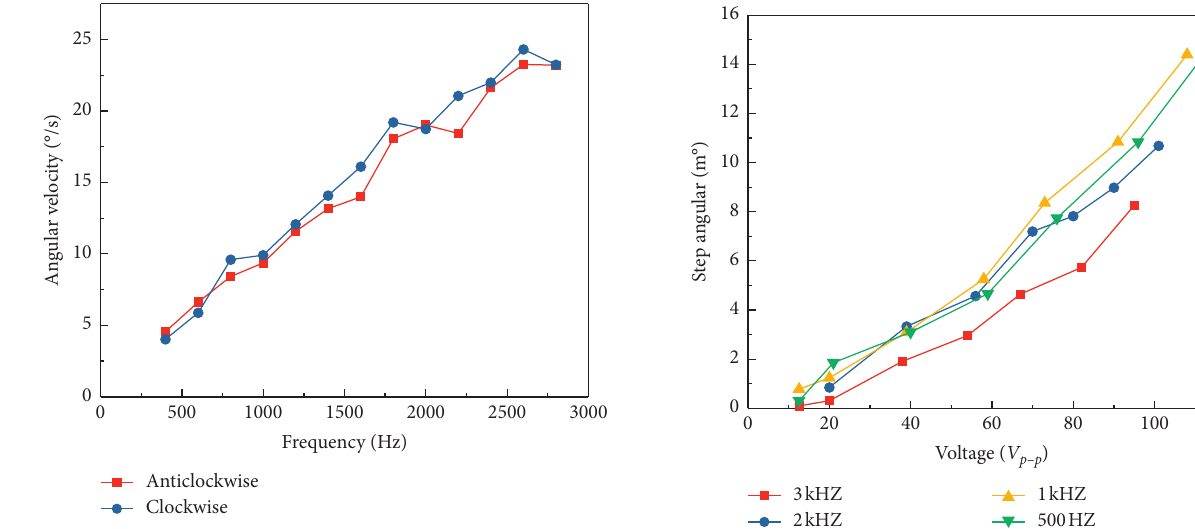
Figure 15: Step angular under different applied voltages.